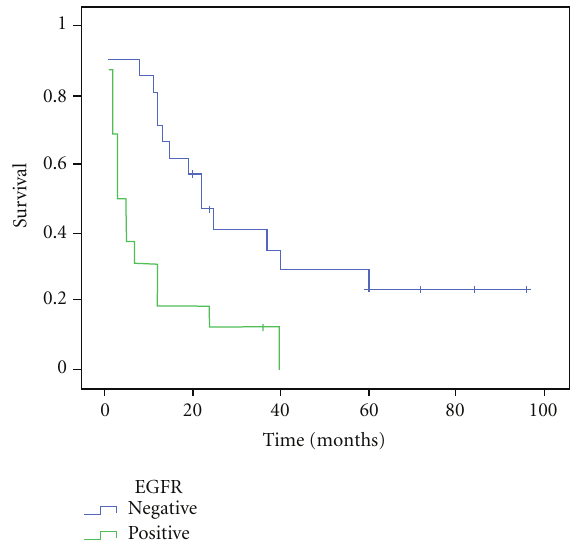
Figure 2: Survival curve (Kaplan-Meier) in patients with and without EGFR expression (4 patients excluded due to surgery- related mortality) ( P = 0 .